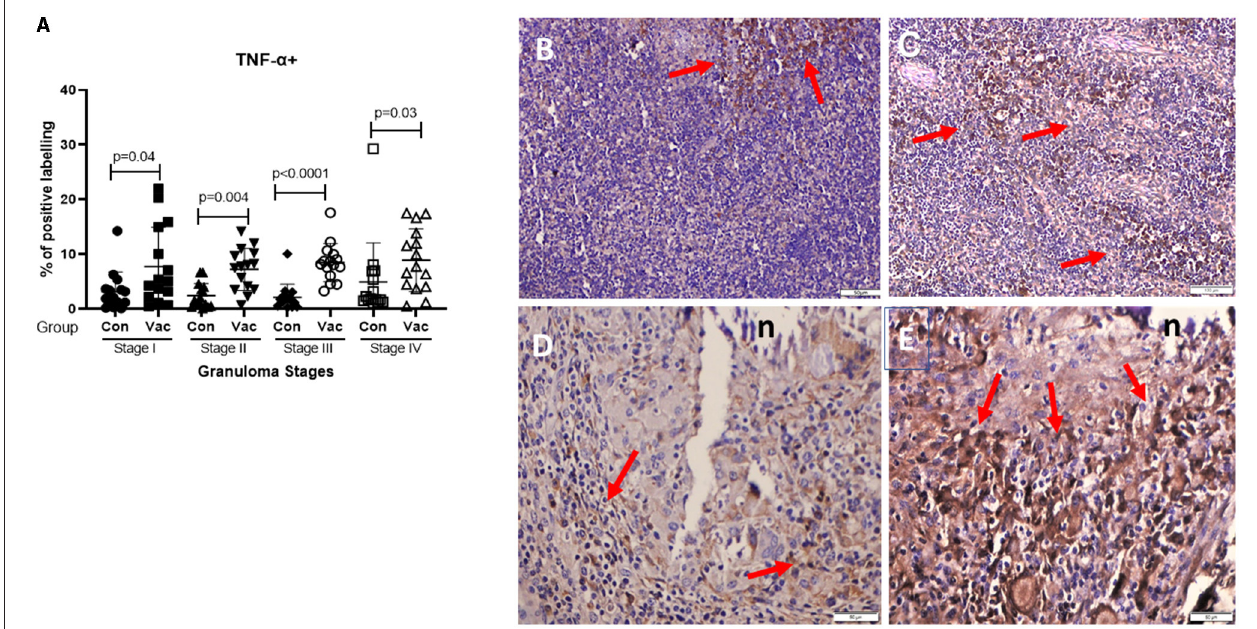
FIGURE 4 | Immunolabelling for TNF- α + (ABC IHC stain, DAB brown chromogen). (A) Comparison of TNF- α + distribution in different granuloma stages of BCG vaccinated (Vac) and non-vaccinated (Con) calves. (B) Stage I granuloma from non-vaccinated calf with few number of TNF- α stained macrophages (arrows), (C) Stage I from BCG vaccinated calf with more positively stained macrophages (arrows). (D) Stage IV granuloma from non-vaccinated calf with moderate number of positive cells (arrows). (E) Stage IV granuloma from BCG vaccinated calf with abundance of positively stained cells (arrows). Bar equals 100 µ m in (B,C) , and 50 µ m in (D,E) . n, necrotic core.